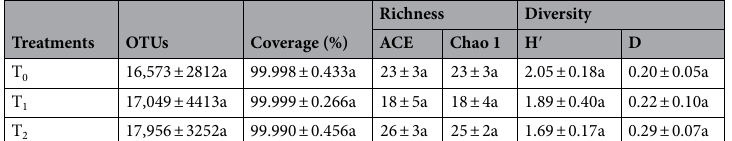
Treatments OTUs Coverage